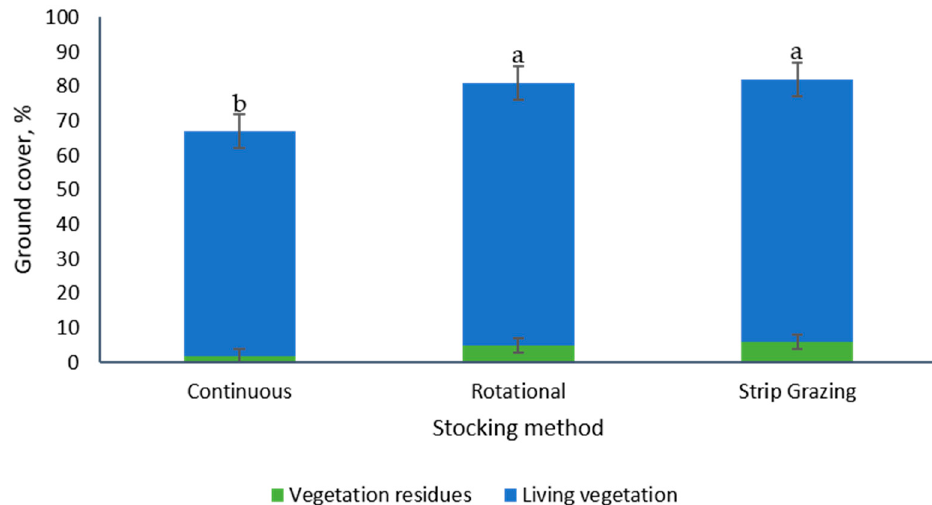
Figure 10. Ground cover (%) in tall fescue paddocks managed with growing-finishing pigs four weeks after the second grazing period. a, b: means displaying the same letter are not significantly different at the 5% level of probability as indicated by the Multiple Comparisons test—simulate option. Data are the means of three field replicates. Errors bars represent plus or minus one standard error of the mean.